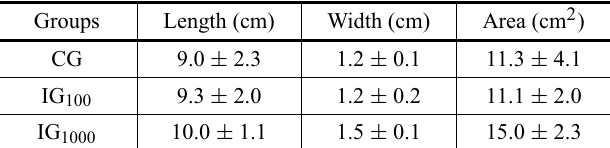
Mean and standard deviation in length, width and area of the colon of Swiss male mice infected by the strain Y of T. cruzi (IG 100 and IG 1000 ) at 75 dpi – days post inoculation and the non-infected controls (CG). Groups